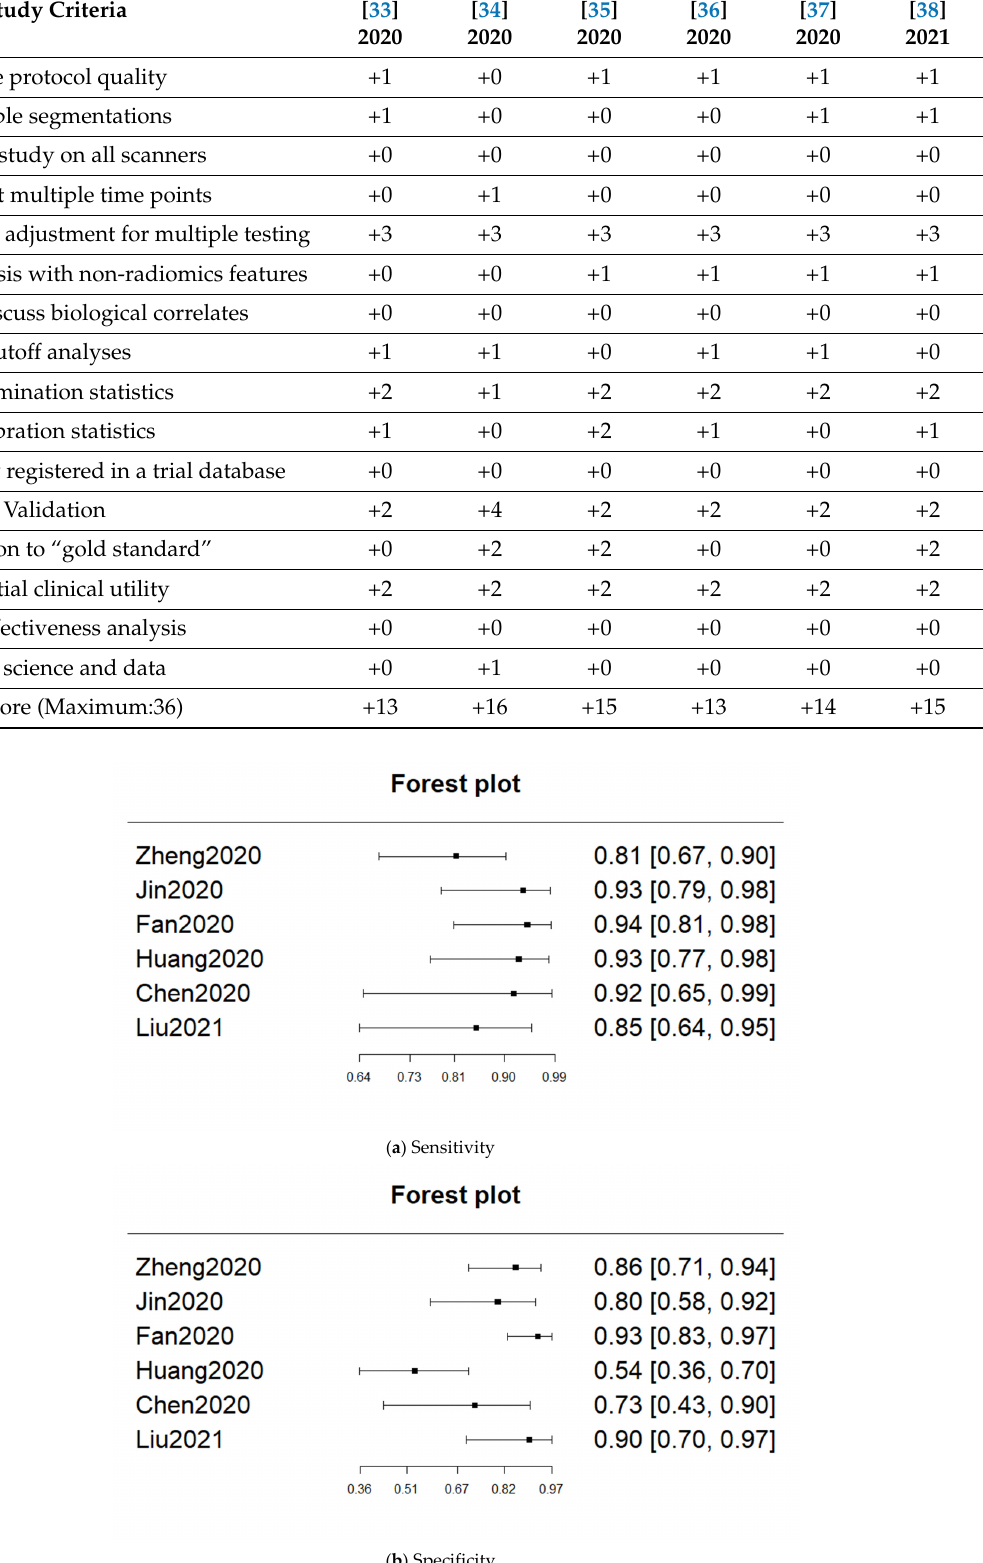
Figure 3. Forest plots for sensitivity and specificity.